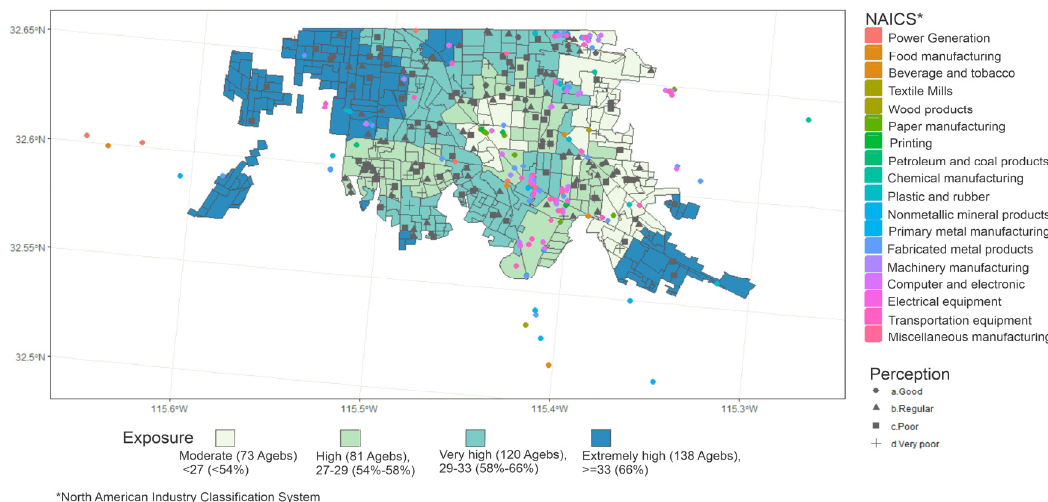
Figure 7. Spatial distribution of the responses about the perception of the current state of air quality, the location of stationary sources of pollution and the estimated categories of exposure to PM 10 (PM 10 concentration from the data of monitoring sites from 2015); localized industries correspond to those with more than 30 employees, and that belong to subsectors 221, 311–313, 321–327, 331–336 and 339 according to the North American Industry Classification System.